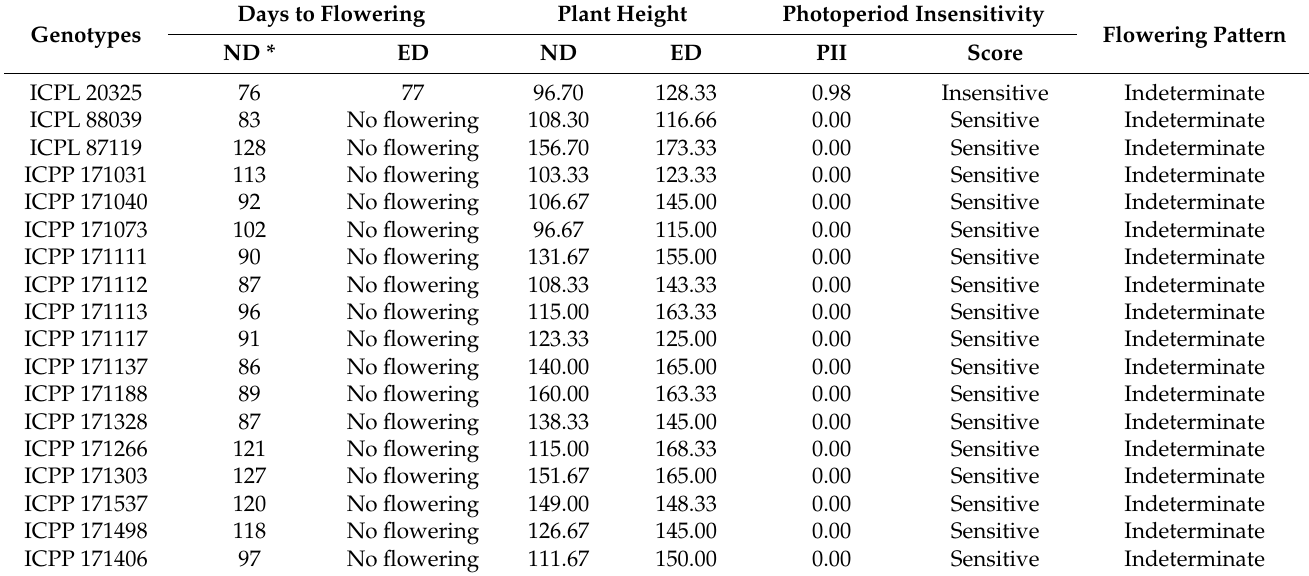
Table 4. Days to flowering and plant height under different photoperiod treatments and photoperiod insensitivity indexes of the early and mid-early maturing pigeonpea introgression lines at ICRISAT, Patancheru,